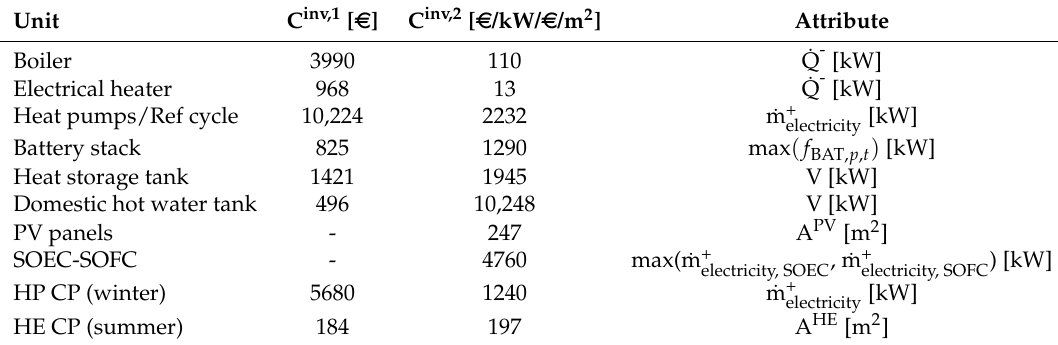
Table A16. Parameters for